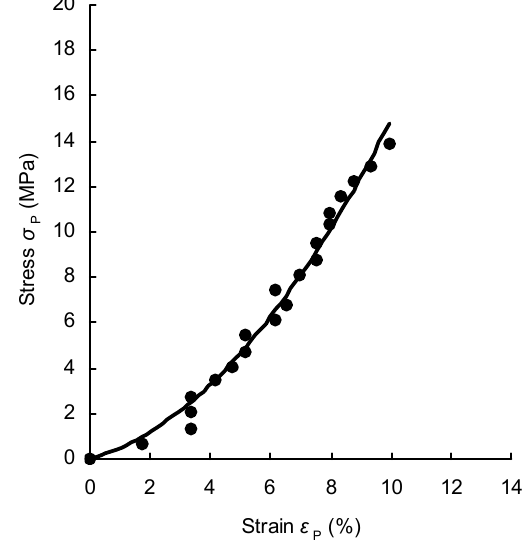
Fig. 4 Typical stress-strain curve of the patellar